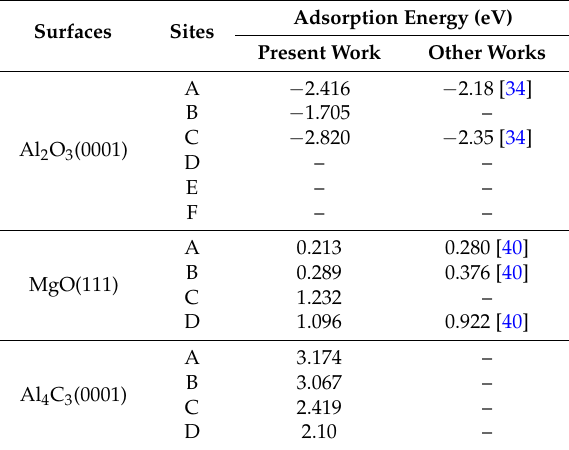
Table 5. Adsorption energy of hydrogen on Al 2 O 3 (0001), MgO(111) and Al 4 C 3 (0001).